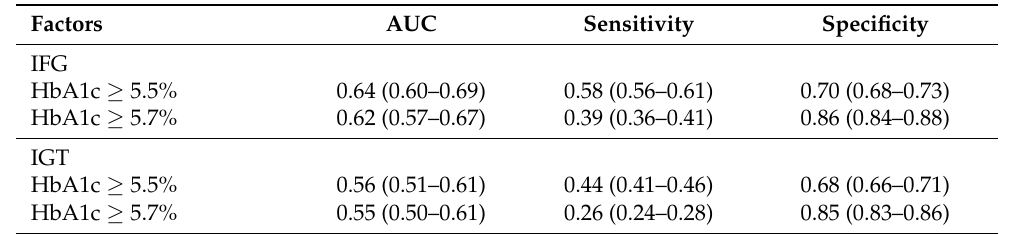
Table 3. Performance of HbA1c ≥ 5.5% or HbA1c ≥ 5.7% in relation to parameters of glucose dysmetabolism, beta-cell dysfunction or cardiometabolic risk